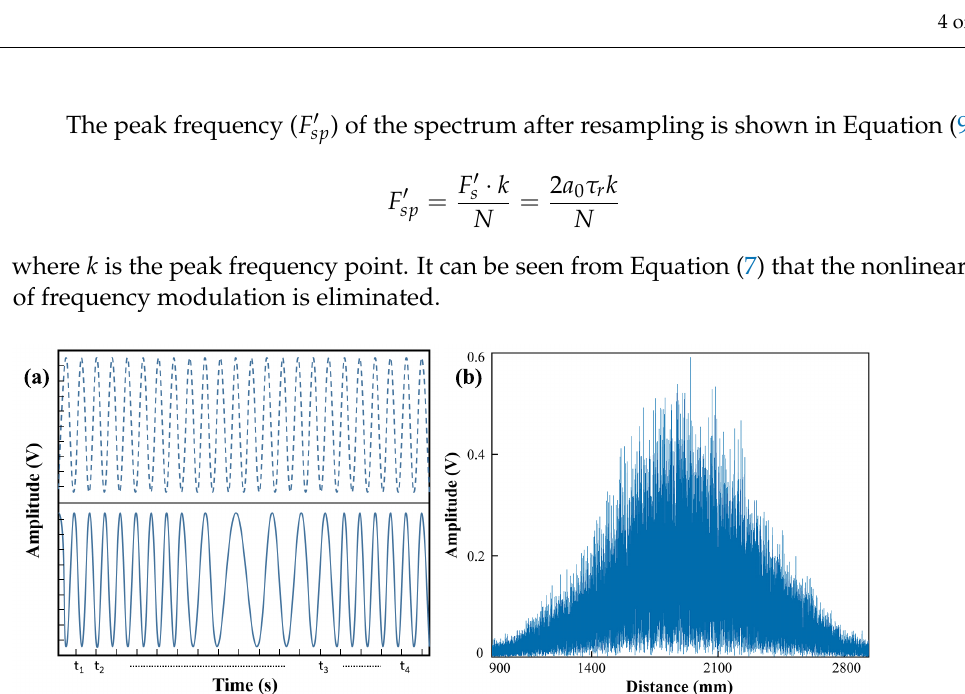
Figure 2. Nonlinear frequency modulation. ( a ) the beat signal comparison, ( b ) widened spectrum (FWHM) of beat signal.